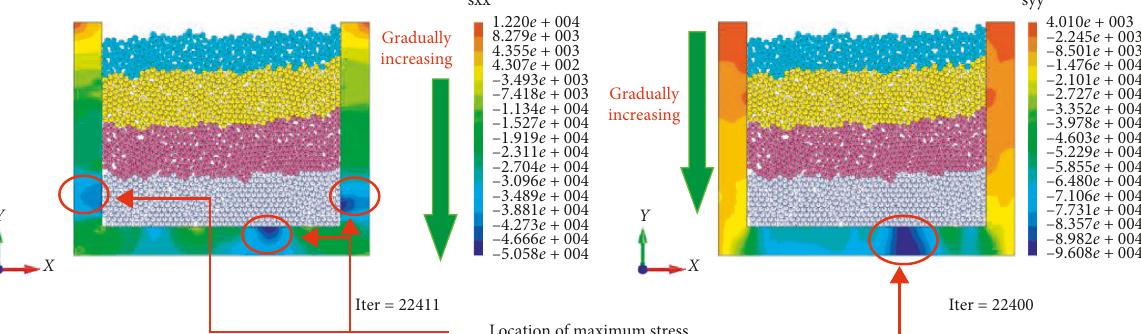
Figure 6: Collapsed body stress cloud